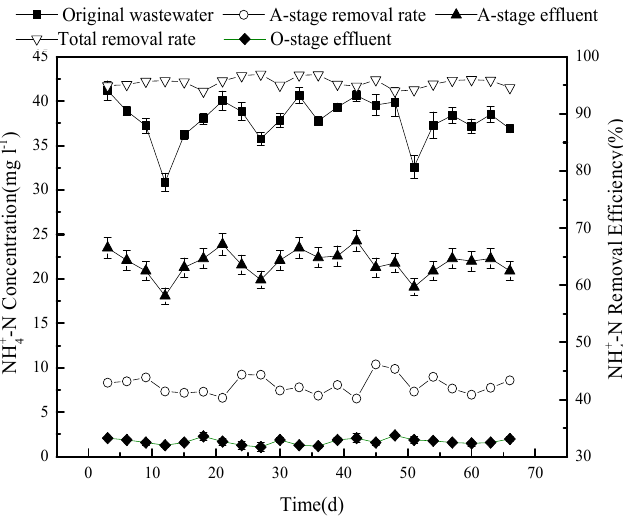
Figure 5. The concentration and removal efficiency of NH 4+ -N in the system. Figure 4. The concentration and removal efficiency of NH 4+ -N in the